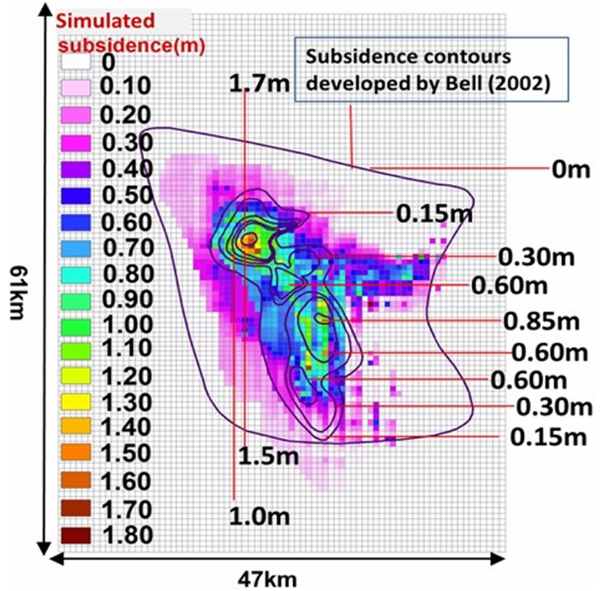
Figure 5. Simulated subsidence after 2002 compared with observed subsidence (solid lines) from Bell (2002).